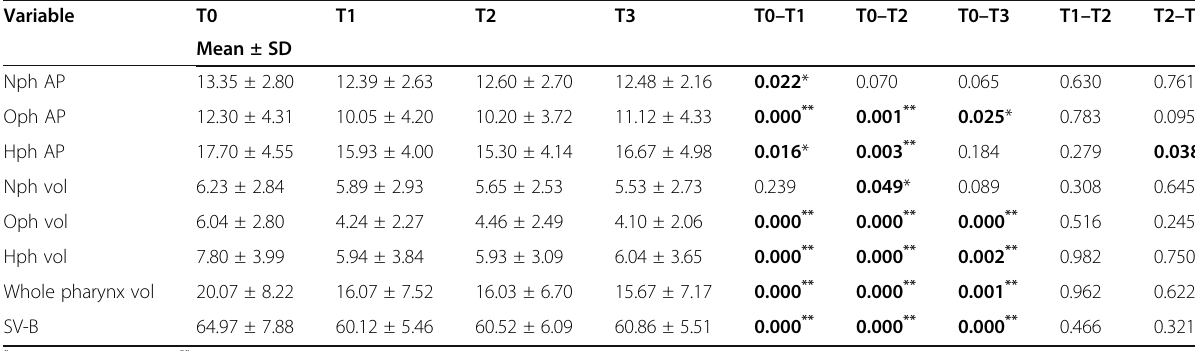
Table 4 Measurements and comparison of the pharyngeal airway in group 1 (BSSRO) Variable